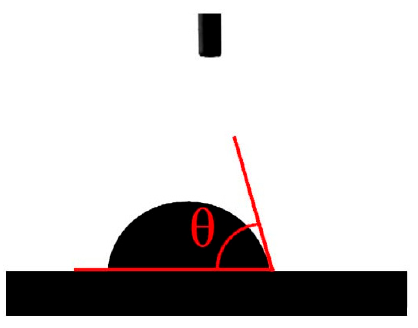
Figure 5. Schematic of contact angle testing